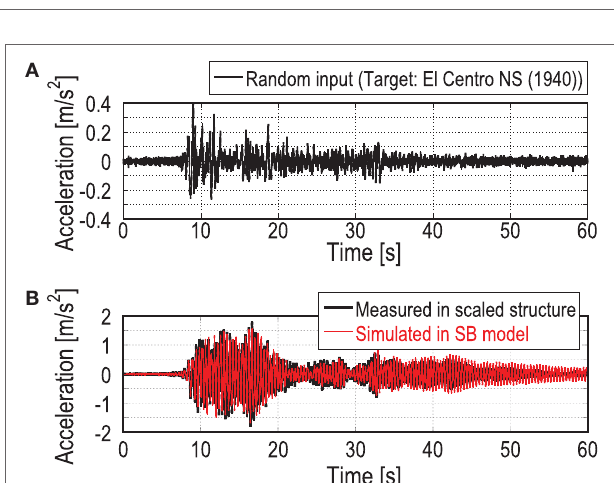
FIGURE 13 | Identified transfer function for horizontal and rotational responses.